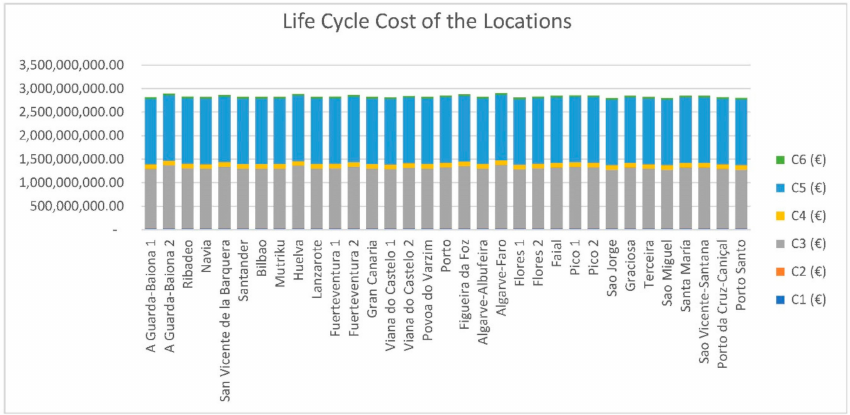
Figure 8. Life-cycle cost of the